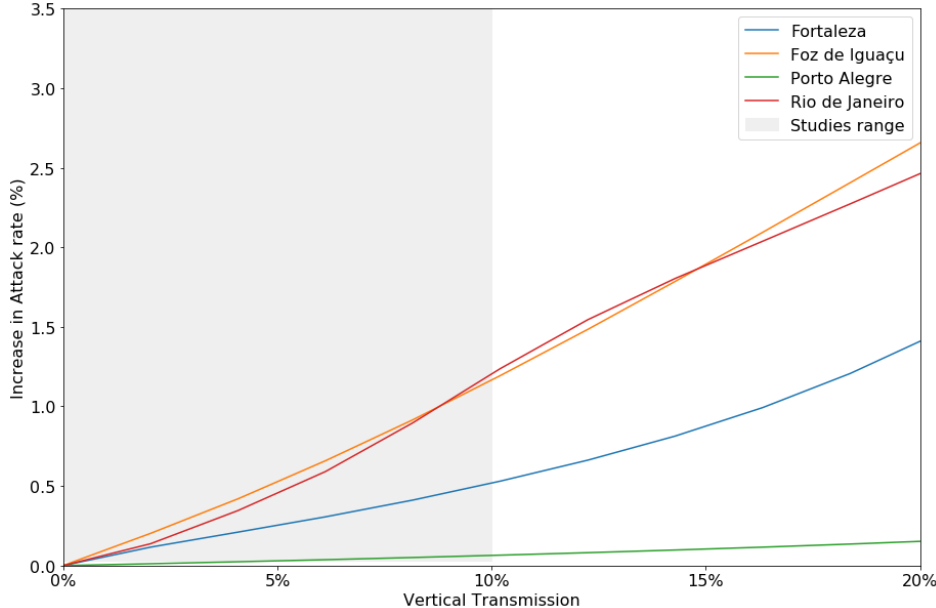
Figure 6. Increased attack rates (%) with different vertical transmission levels. The gray area indicates the range of vertical transmission reported in the